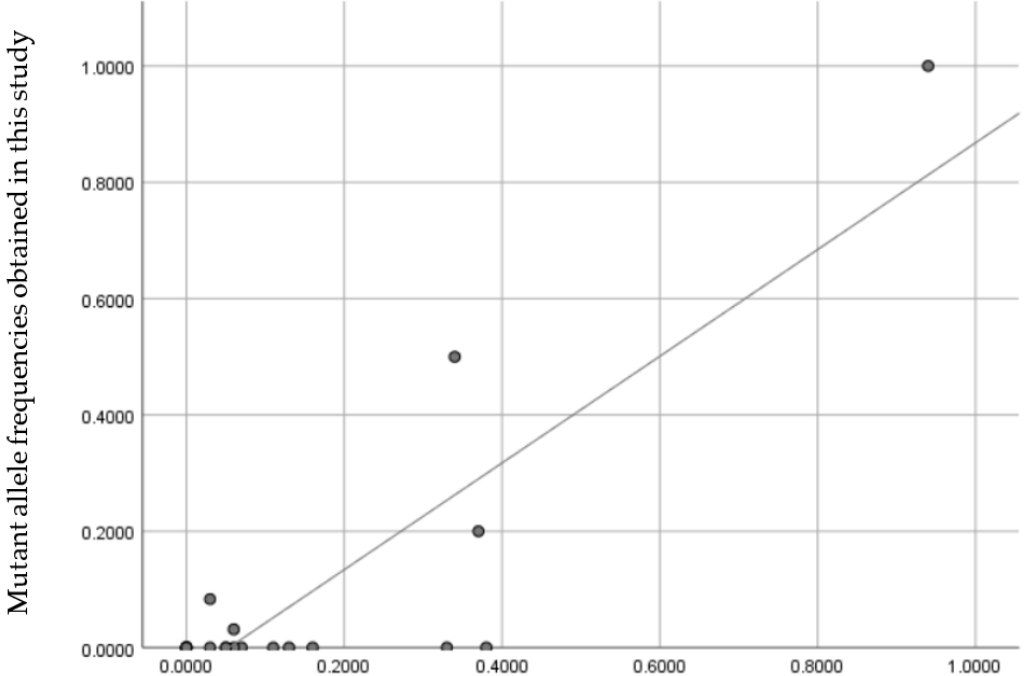
Figure 2. Scatter plot showing the correlation between the mutant allele frequency obtained in our study and the mutant allele frequency obtained by Zeng et al. 2014 [22]. Each point represents a dog breed. The source data for the figure is presented in Table S1.